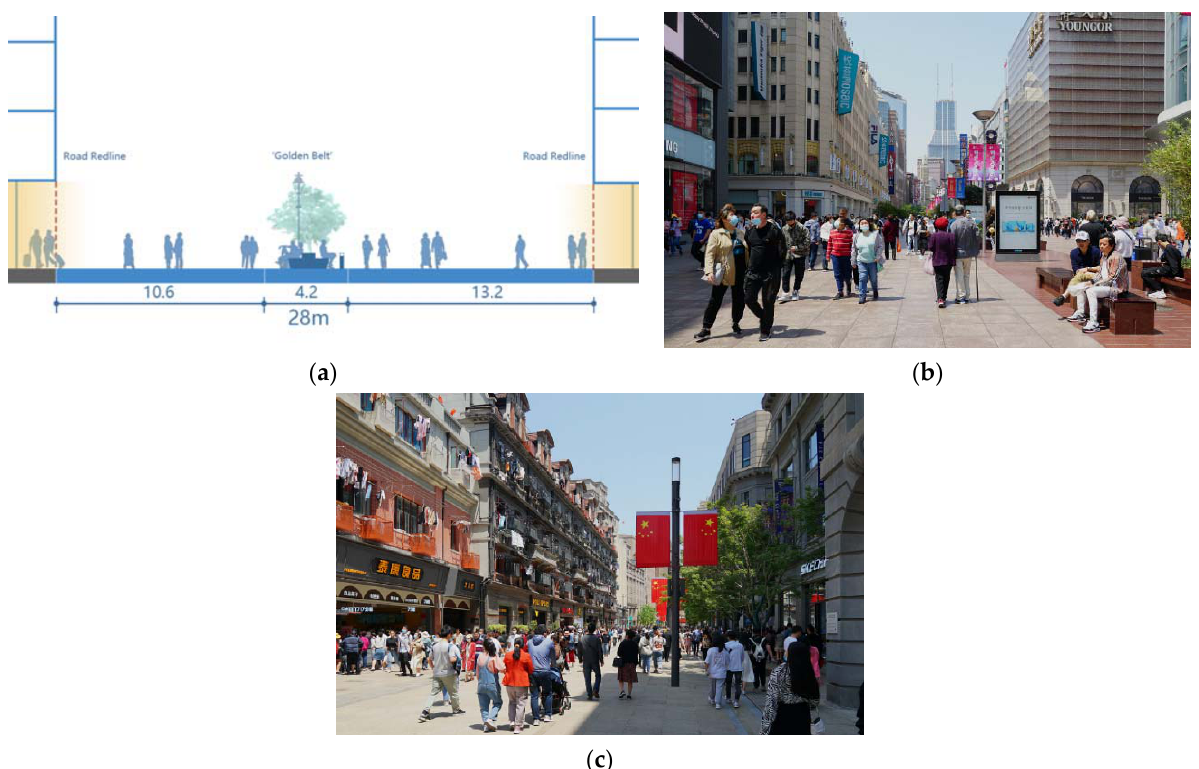
Figure 11. Section of the pedestrian street ( a ), the “golden belt” ( b ) and the renewal in 2019 ( c ). Source ( a ): drawn by Li Yu; source ( b , c ): photo by Li Yu, 2021.